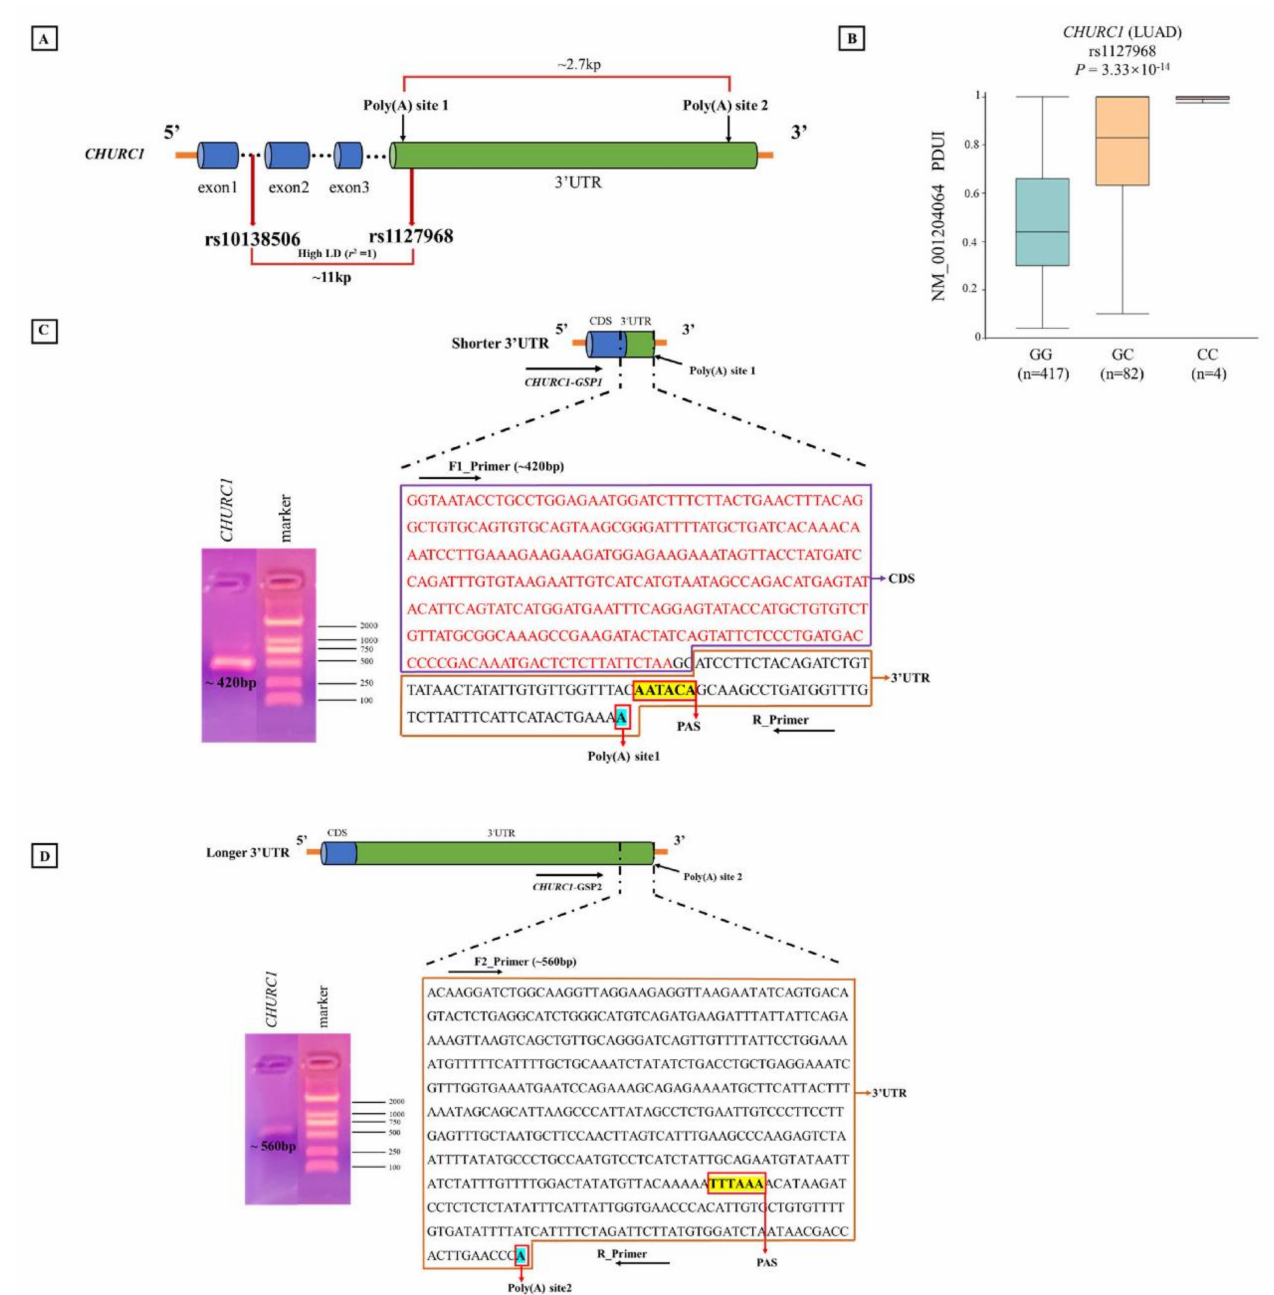
Figure 5. 3 (cid:48) RACE experiment determining poly(A) sites of CHURC1 . ( A ) The location of two poly(A) sites in CHURC1 ; ( B ) the relationship between apaQTL-SNP rs1127968 and PDUI values of CHURC1 in LUAD; ( C ) the schematic diagram of shorter 3 (cid:48) UTR of CHURC1 transcript and the sequence of the PCR product (~420 bp); ( D ) the schematic diagram of longer 3 (cid:48) UTR in the CHURC1 transcript and sequence of the PCR product (~560 bp). 3 (cid:48) RACE, 3 (cid:48) -rapid amplification of cDNA ends; LD, linkage disequilibrium; apaQTL, alternative polyadenylation quantitative trait loci; SNP, single nucleotide polymorphisms; PDUI, percentage of distal poly(A) site usage index; 3 (cid:48) UTR, 3 (cid:48) untranslated region; LUAD, lung adenocarcinoma; CDS, coding sequence; PAS, polyadenylation signal; GSP, gene-specific forward